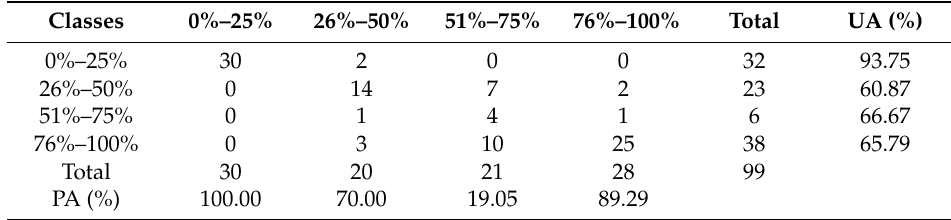
Table 5. The confusion matrix and summary error statistics for seagrass cover mapped from the Worldview-2 image validated against the reference field data of seagrass percentage cover estimated from photo transects. PA is Producer’s accuracy; UA is User’s.